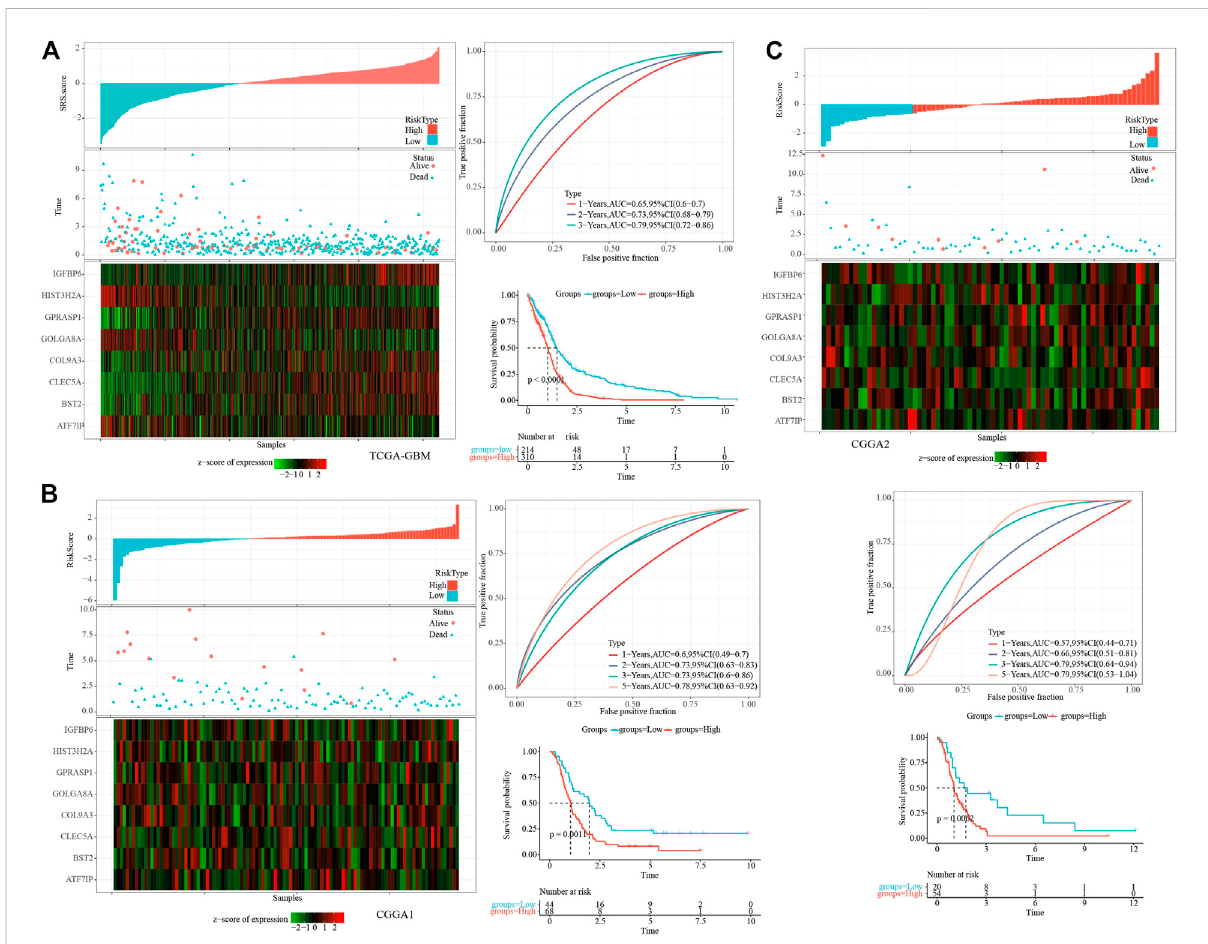
FIGURE 7 Establishment and test of SRSscore model. (A) SRS.score, survival time and survival state, and expression of senescence-related genes in the TCGA-GBM cohort; ROC curve and AUC of the SRS.score classi fi cation in the TCGA-GBM cohort; KM survival curve distribution of SRS.score in the TCGA-GBMcohort; (B) SRS.score,survivaltimeandsurvivalstate,andexpressionofsenescence-relatedgenesintheCGGA1cohort;ROCcurveand AUCoftheSRS.scoreclassi fi cationintheCGGA1cohort;KMsurvivalcurvedistributionofSRS.scoreintheCGGA1cohort; (C)